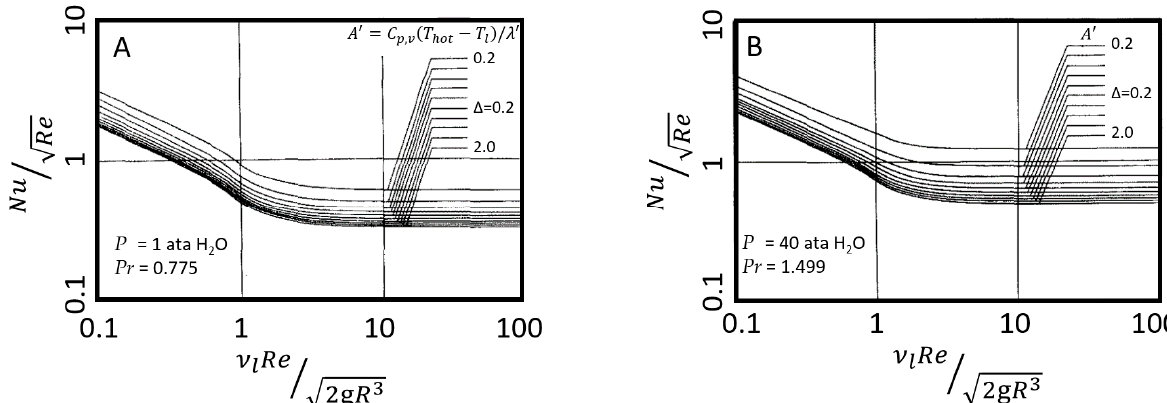
Figure 9. Ratio of Nusselt ( Nu ) number and square root of Reynolds ( Re ) number Nu/ √ Re in water with forced convection film boiling (Y-axis) as a function of sphere size ( R ) and relative velocity ( v l , X-axis) for a variation in energy content A’ = C p,v ( T hot - T l )/ λ ’ at different external conditions (adapted from Reference [74]): ( A ) 1 ata H 2 O; ( B ) 40 ata H 2 O (ata is an old pressure unit for the total pressure (hydrostatic + atmospheric)).